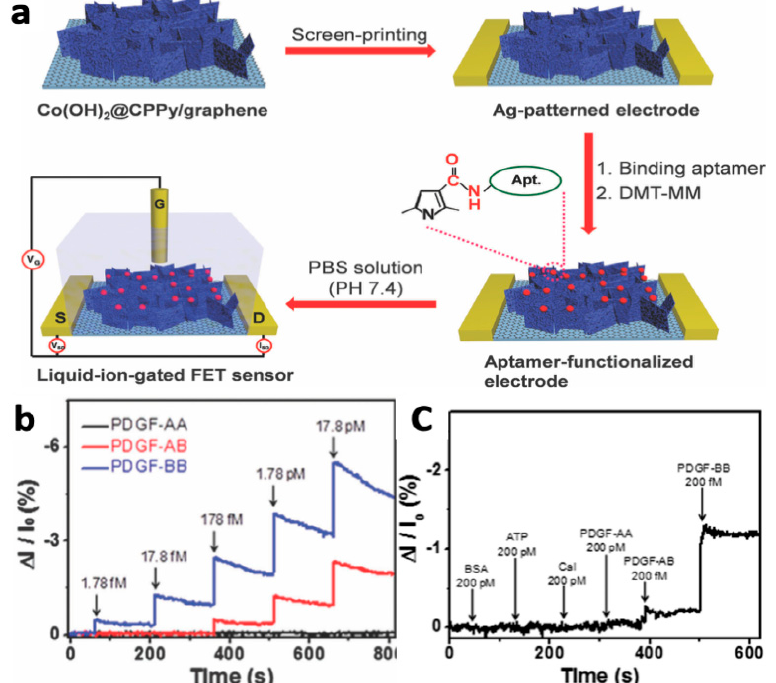
Figure 23. ( a ) Fabrication of a FET sensor. ( b ) Normalized current change response to varying concentrations of three forms of PDGF or ( c ) equal concentrations of PDGF-BB or a series of interfering agents, demonstrating high sensitivity and selectivity for PDGF-BB [112]. Reprinted with permission